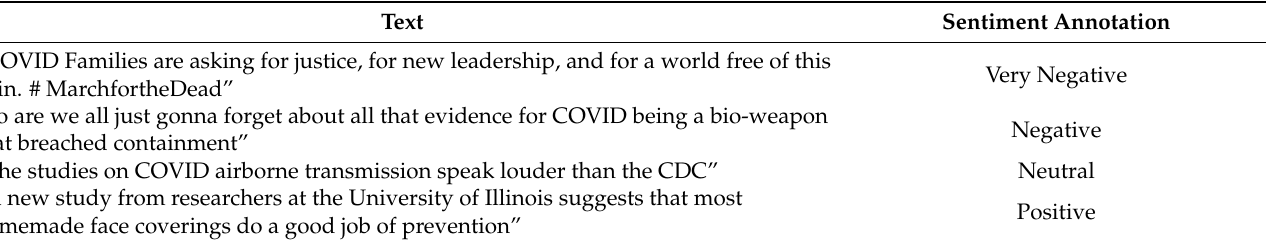
Table 2. Examples of sentiment analysis on collected